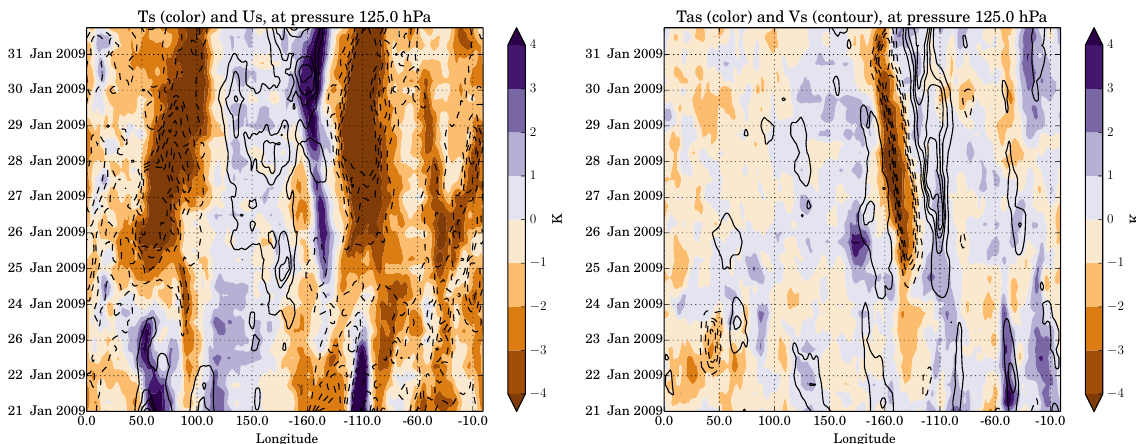
Tas (color) and Vs (contour), at pressure 125.0 hPa